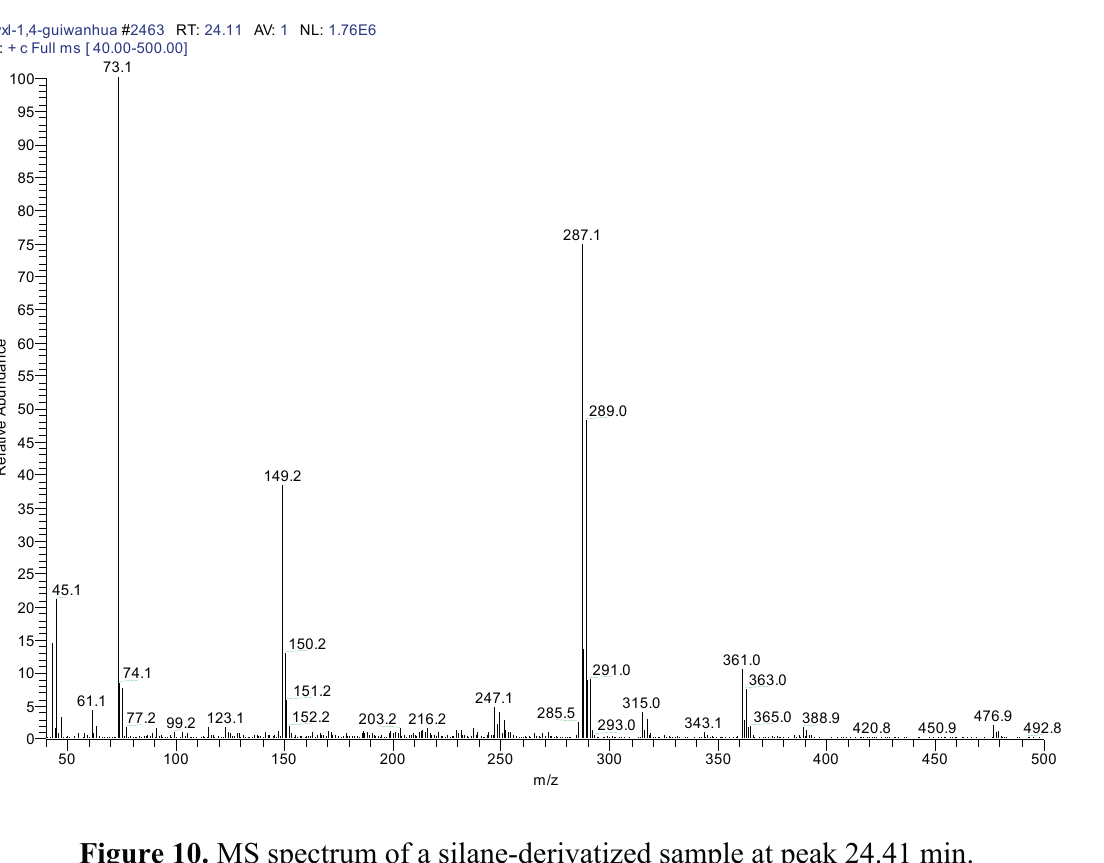
Figure 9. GC spectrum of a silane-derivatized sample (A. the silane derivatives of dichlorinated naphthol; B. the silane derivatives of dihydroxyl dichlorinated naphthalene).